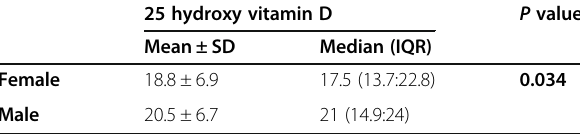
Table 1 Descriptive data of the study group Table 2 25 hydroxy vitamin D levels in both